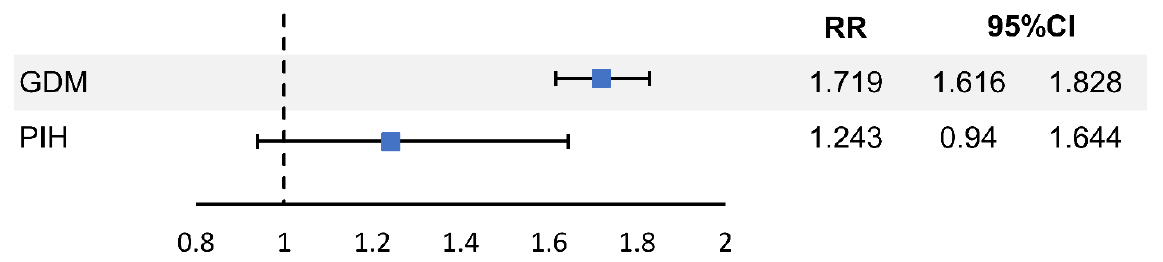
Figure 2. Adjusted relative risks of GDM and PIH in pregnant women with PCOS. GDM — gesta- tional diabetes mellitus; PCOS — polycystic ovary syndrome; PIH — pregnancy-induced hyperten- sion; RR — relative risk.